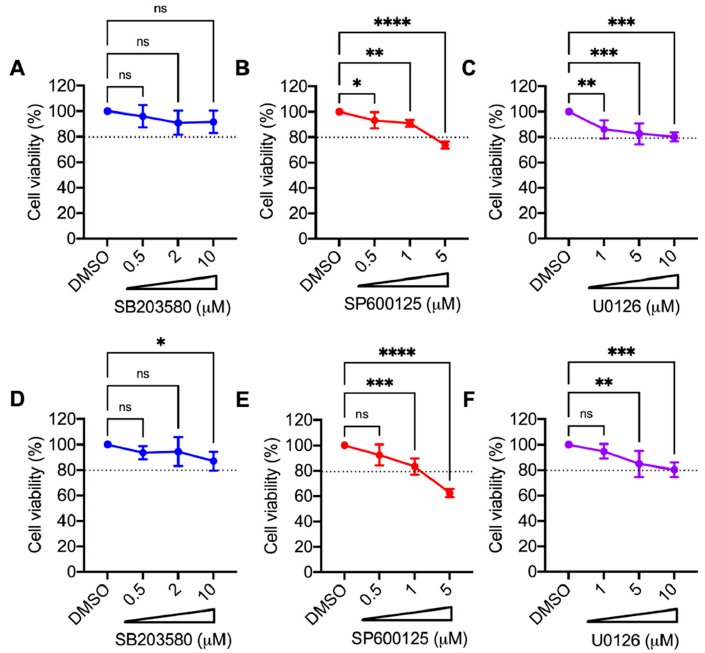
Figure 2. Toxicity of MAPK inhibitors SB203580, SP600125, and U0126 in HDFs or HeLa cells. HDFs ( A – C ) or HeLa ( D – F ) cells were treated with the indicated concentrations of each MAPK inhibitor, or DMSO (0.1%) as a control, and after 24 h of incubation, cell viability was assessed using the MTT method. Statistically significant differences were assessed with the One-way ANOVA test followed by Dunnett’s post-test: * p < 0.05; ** p < 0.01; *** p < 0.001; **** p < 0.0001; ns: non-significant. The dotted line on the graphs indicates a cell viability of 80%.